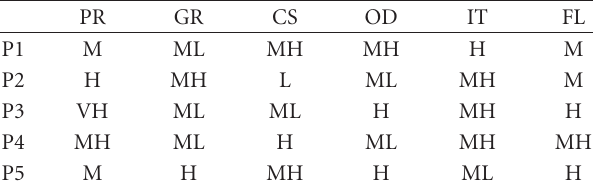
Table 5: Fuzzy evaluation matrix for